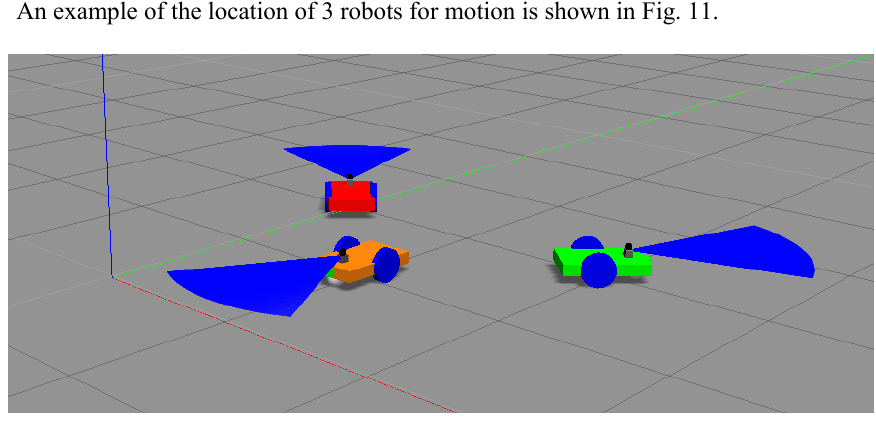
Fig. 11. Model of three robots in the gazebo at the beginning of the